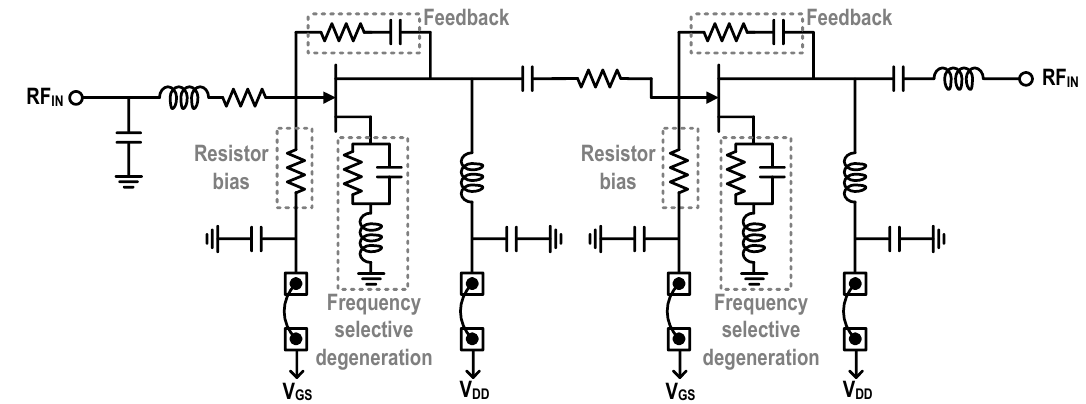
Figure 5. Overall schematic diagram of the proposed broadband